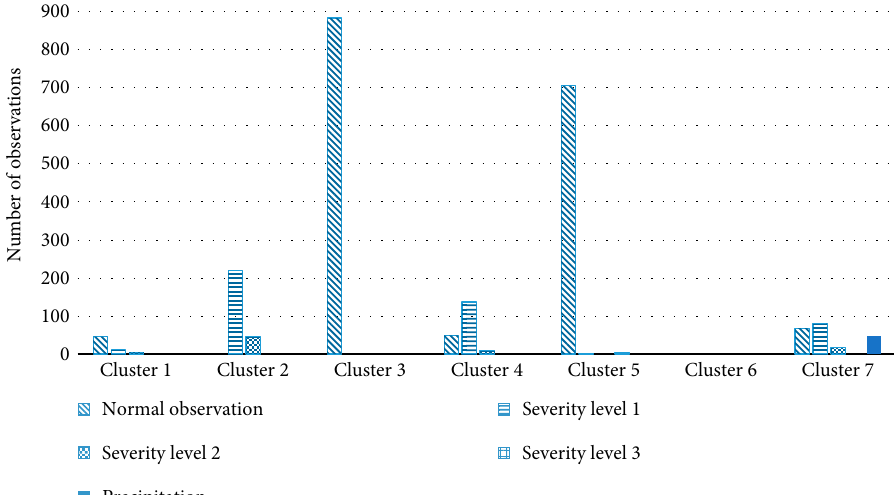
Figure 10: Observations with different levels of severity and precipitation in the clusters identified by the K-means with PCs method.